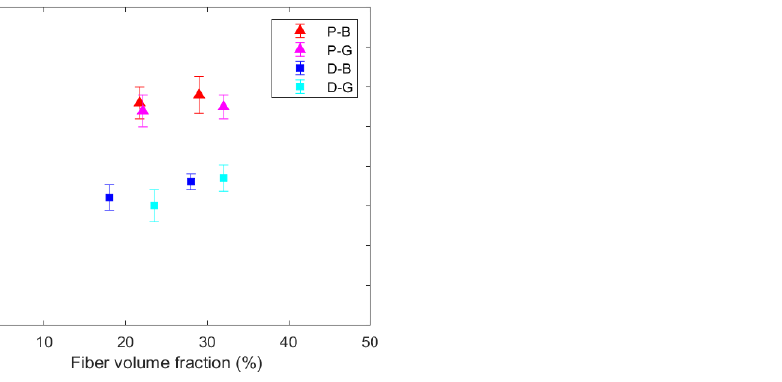
Figure 9. Increase rate of the mechanical properties of the GF/PA6 specimen (when increasing fiber content from 40 wt% to 50 wt%). Figure 10. OM images of the GF fiber lengths from the pultrusion and direct extrusion processes: ( a ) pultrusion; ( b ) direct. Figure 11. SEM images of the GF/PA6 interface from the pultrusion and direct extrusion processes: ( a ) pultrusion; ( b ) direct.